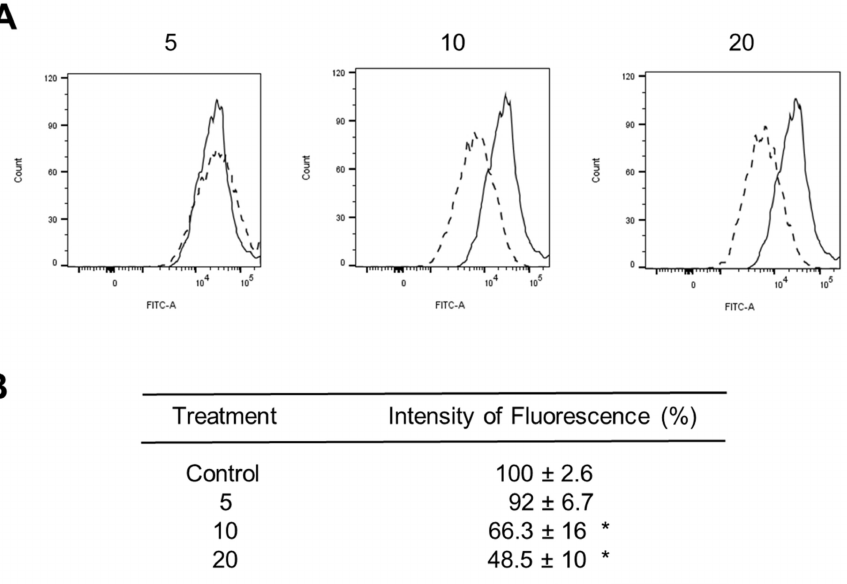
Figure 8. ZnO NPs effect on ∆Ψ m. Cells (1 × 10 6 ) were exposed to 0 (Control), 5, 10, and 20 µ g/cm 2 of ZnO NPs for 1 h, and ∆Ψ m was measured using Rh123 and flow cytometry. In ( A ), a representative experiment is shown where the continuous line represents control cells, and the dashed line represents treated cells. In ( B ), results were expressed as mean ± standard deviation of three independent experiments with normalized vs. control cells set as 100%. * p < 0.05 compared with